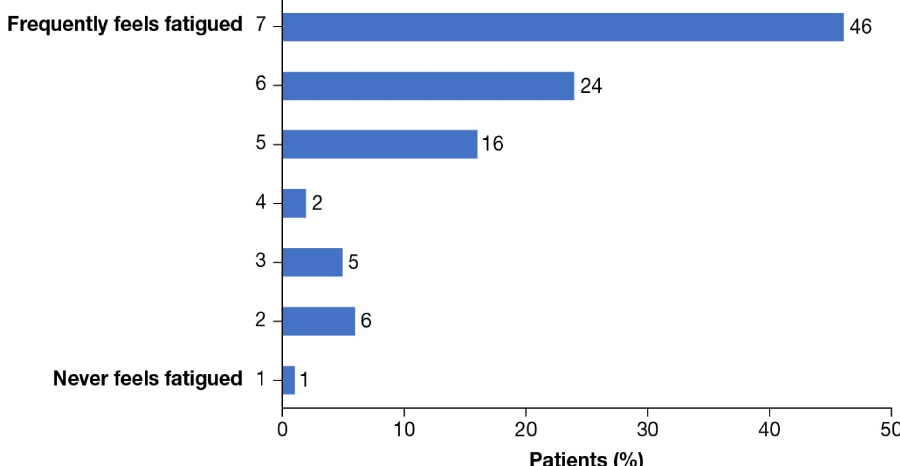
Figure 3. Patients reporting fatigue. Patients indicated the level of fatigue they feel leading up to their blood transfusion (7-point scale from “never feels fatigue” to “frequently feels fatigue”).